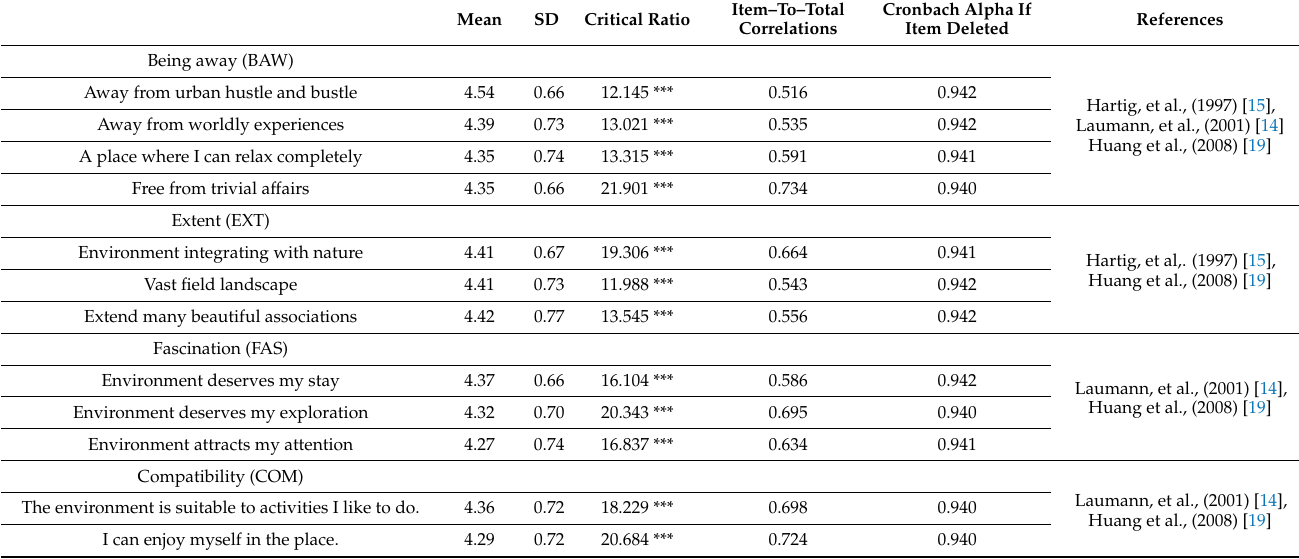
Table 1. Project analysis on the questionnaire